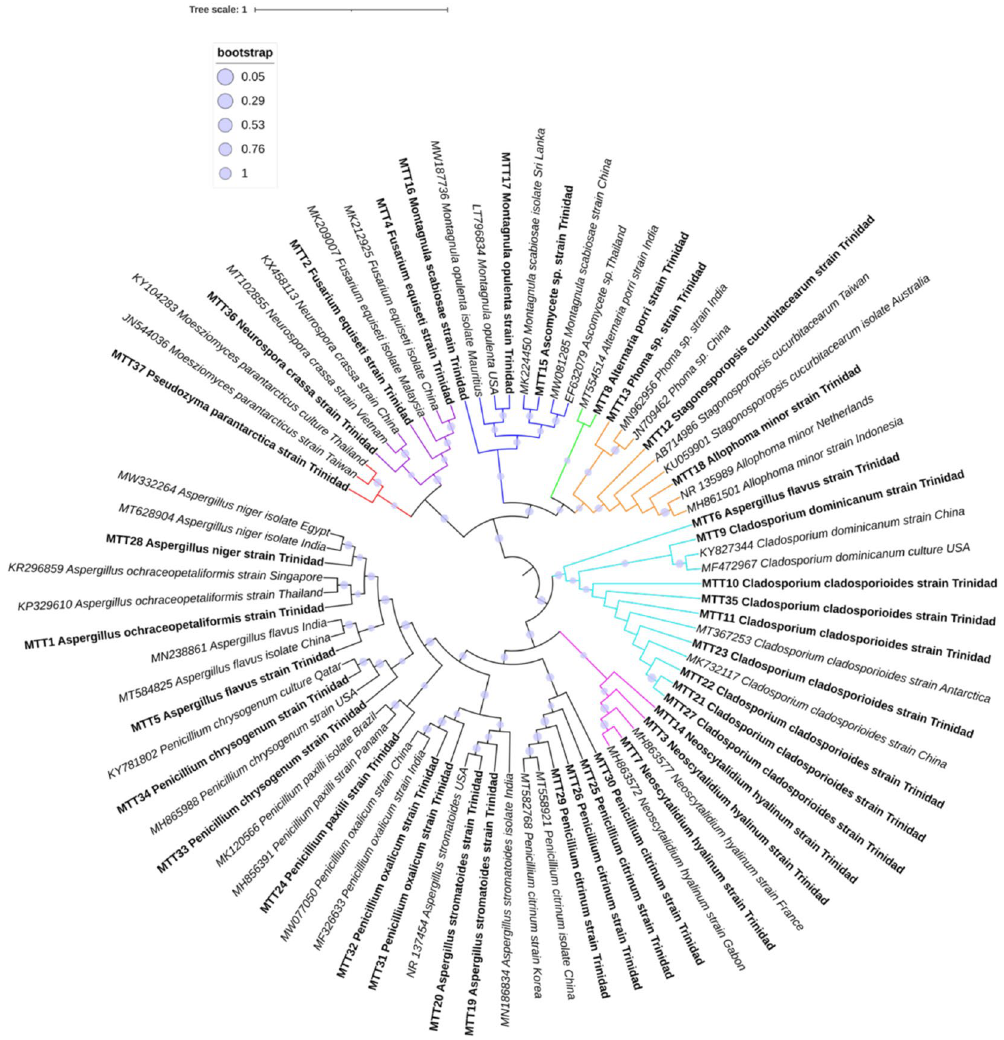
Figure 2. Un-rooted Maximum Likelihood phylogenetic tree for filamentous fungi. Among the 37 fungal species detected in this study, only three fungi ( Aspergillus , Fusarium and Penicillium ) at the genus level have been previously reported as being isolated from crude oil-contaminated sites in Trinidad 6 . The findings of this study described the first report of six novel oil-degrading fungi including Aspergillus ochraceopetaliformis , Fusarium equiseti , Neoscytalidium hyalinum/dimidiatum , Alternaria porri / destruens , Montagnula scabiosae and Montagnula opulenta . Additionally, previously identified species from other studies of Aspergillus flavus , Phoma sp., Cladosporium cladosporioides , Penicillium citrinum , Penicillium paxilli and Aspergillus niger were identified for the first time in Trinidad. (iTOL v6; https:// itol. embl. de/).